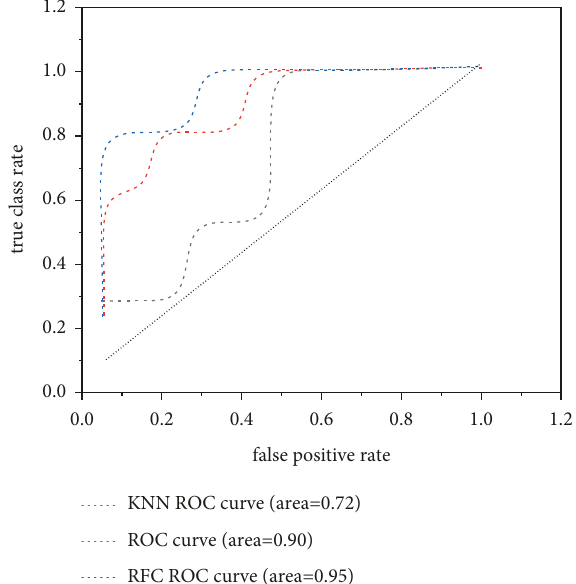
Figure 8: ROC curves of models KNN, LR, and RFC to identify relaxation and moderate stress states.